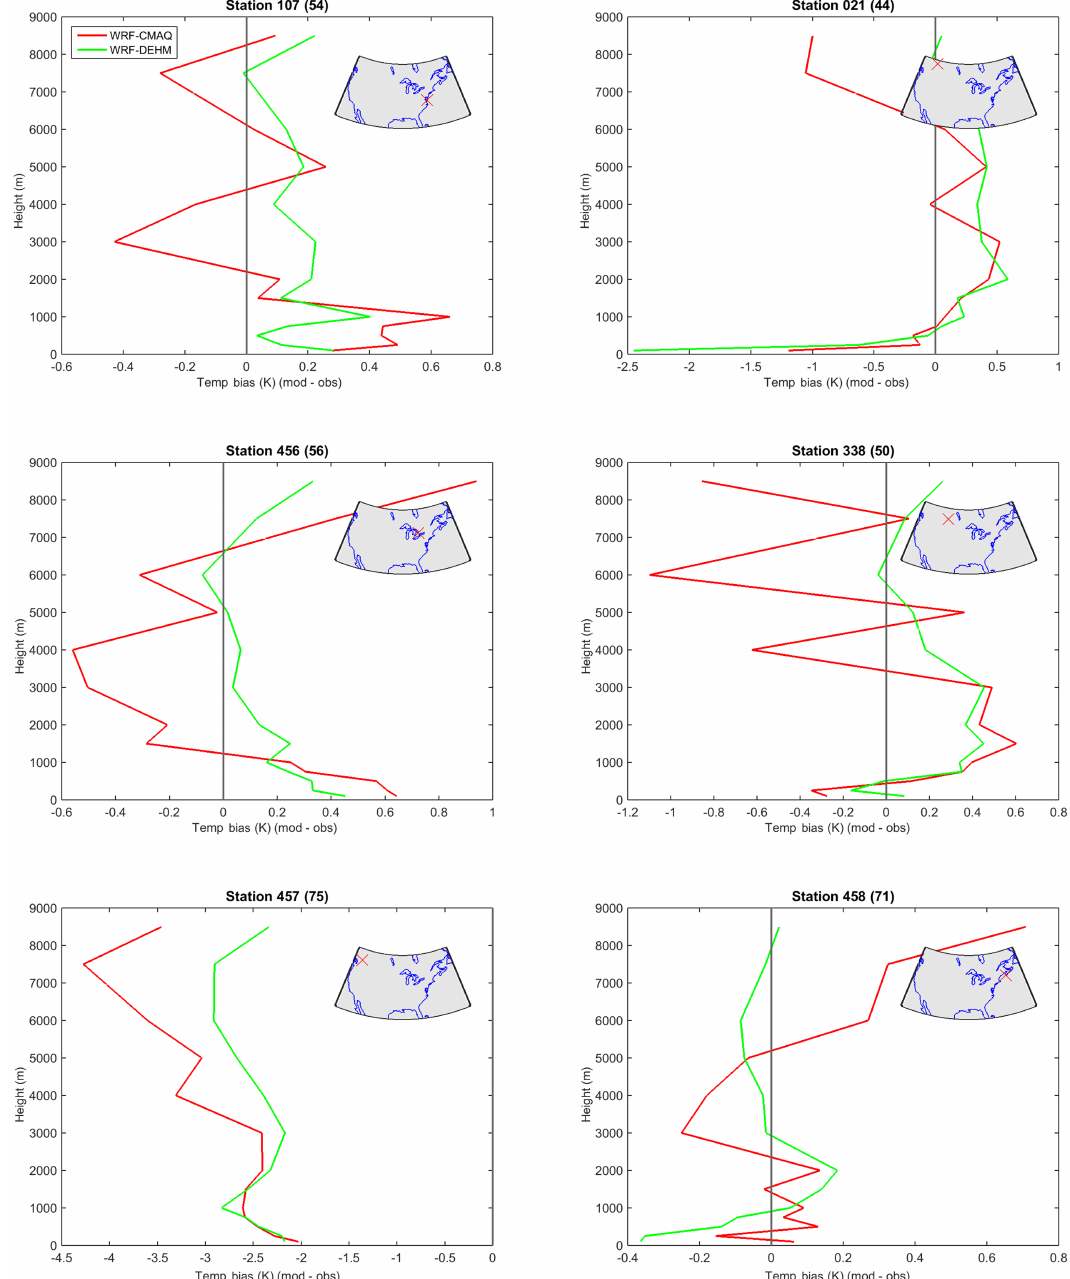
Figure 7. Mean bias (model–observations) for the vertical profiles of temperature measured by ozonesondes launched from the North American locations indicated in the inset map of each panel. The number of hourly profiles available for each site is reported in parentheses at the top of each